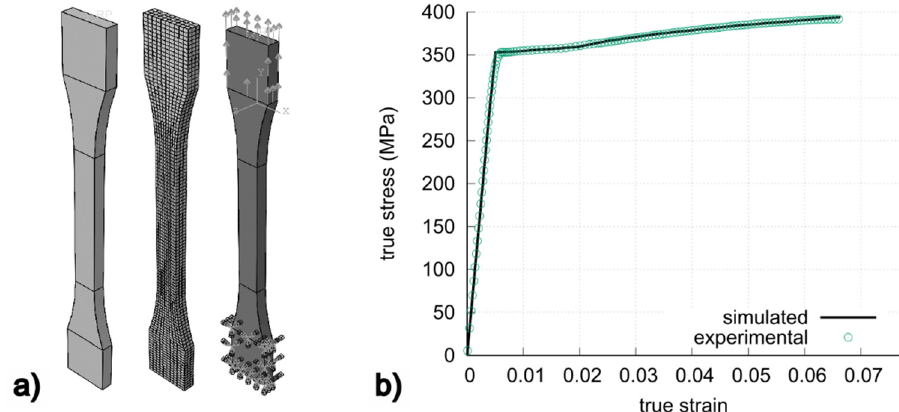
Figure 6. ( a ) Model, mesh, and boundary conditions used in tensile test simulation; ( b ) flow tensile curve of the billet (before ECAE): experimental and simulated. curve of the billet (before ECAE): experimental and